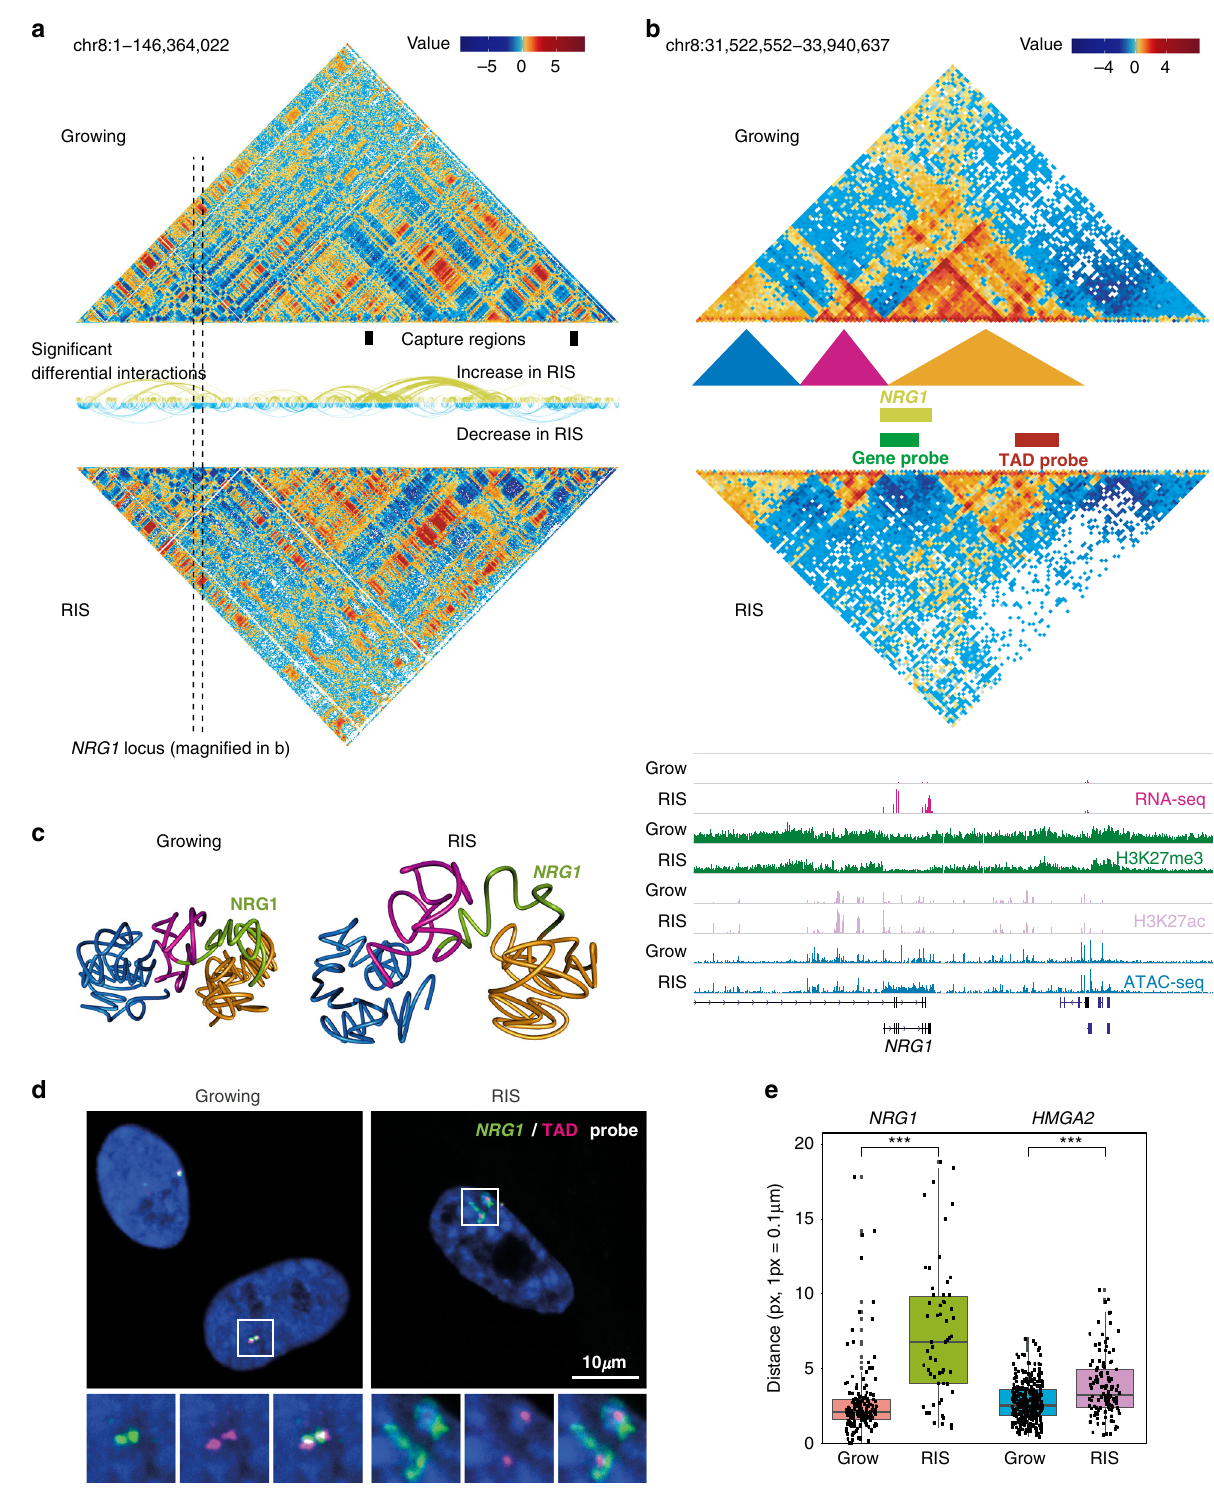
interaction changes for the ones occurring between genes and H3K27me3 regions. To validate the chromatin structural alteration of the two representative genes, NRG1 and HMGA2 , we performed DNA-FISH using BAC probes (probe size is ~155 kb) for gene bodies (gene probes) and the other end of the respective TADs (TAD probes) as depicted in Fig. 1b and Supplementary Fig. 2a. Consistent with our model, the average distance between the gene and TAD probes was very small, often